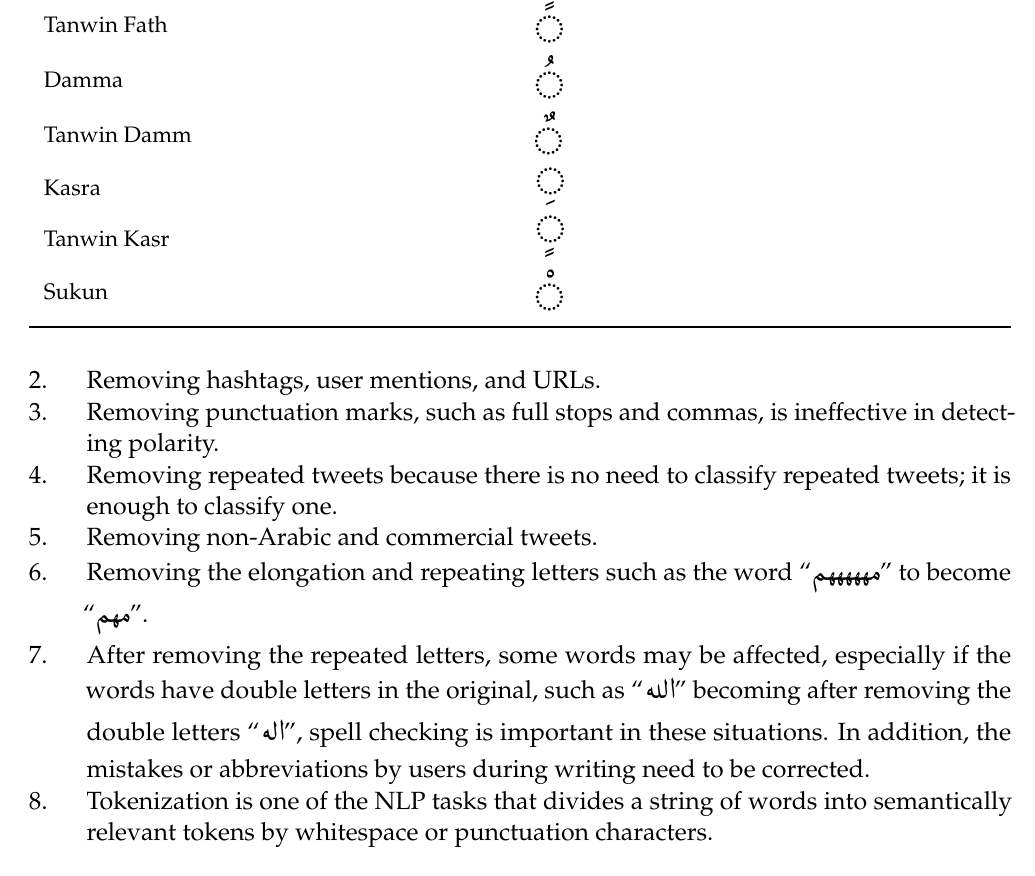
Table 3. Arabic diacritic marks.